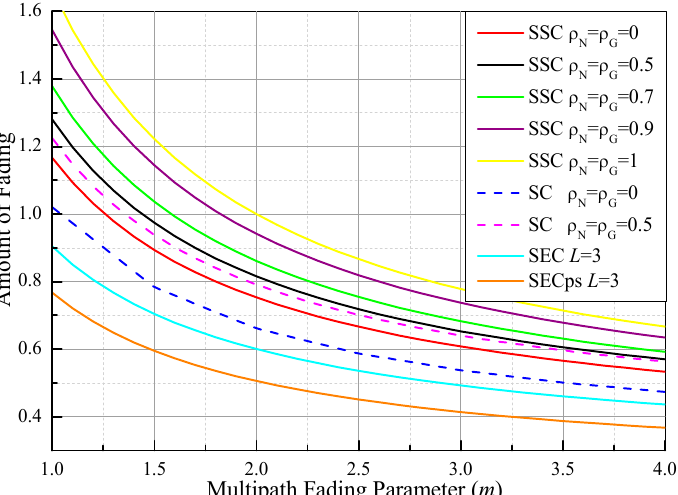
Figure 2. Comparison of the AoF values of different switched diversity systems as functions of the multipath fading parameter ( m ) over Fisher–Snedecor ℱ fading channels, where n = 5, 𝛾̅ = 5 dB, and γ τ = 5 dB.